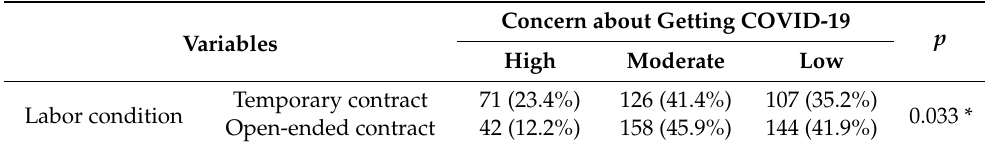
Table 6. Association between concern about the spread of COVID-19 and the labor condition of the